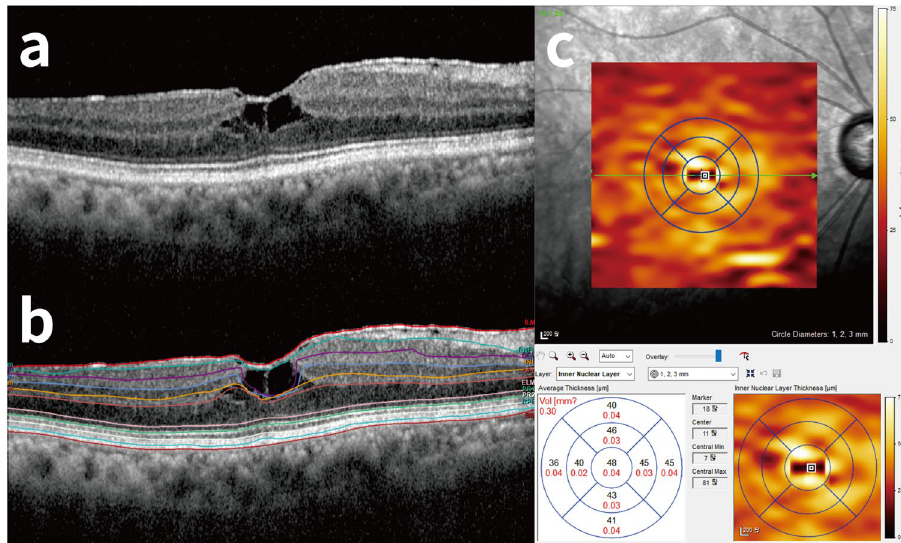
Figure 4. An example of automated retinal layer segmentation with spectral domain-OCT (Spectralis HRA + OCT; Heidelberg Engineering, Heidelberg, Germany). ( a ) A representative case of preoperative cystoid space. ( b ) Automated segmentation of retinal layers was performed by the built-in software (Heidelberg Eye Explorer, version 1.10.2.0; Heidelberg Engineering, Heidelberg, Germany) and manual correction was done afterwards when needed. ( c ) After segmentation, total retinal thickness of central 1 mm diameter region was analyzed. The thickness of nasal inner nuclear layer between central circle and inner ring (the area between 1 and 2 mm diameter circle) was analyzed on preoperative optical coherence tomography (OCT) image and postoperative OCT